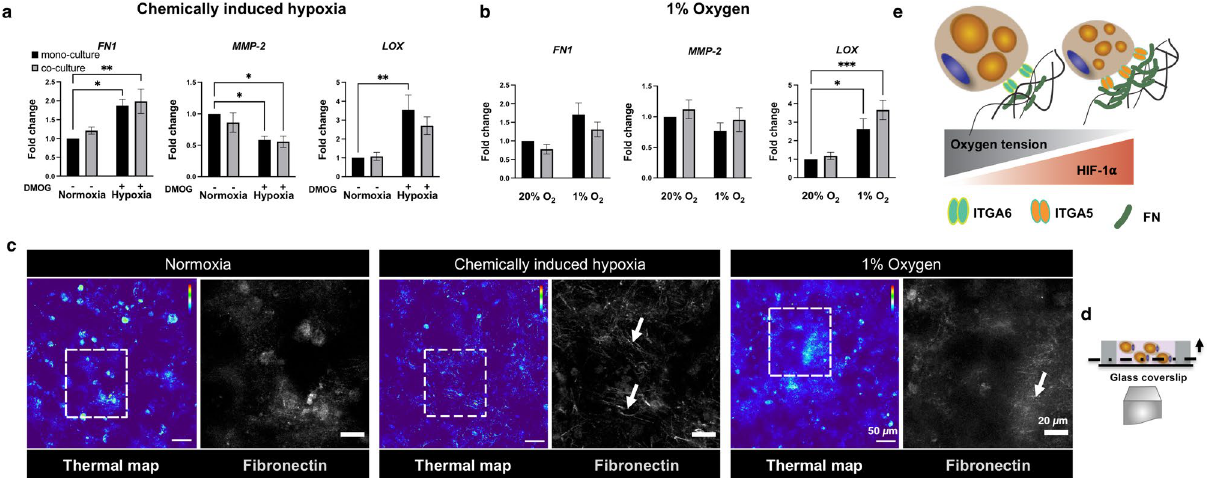
Figure 3. Hypoxia increases fibronectin, FN, and crosslinking gene, LOX , expression and results in a distinct fibronectin matrix assembly. ( a ) FN and LOX are significantly upregulated, while MMP-2 is downregulated in the chemically induced hypoxia (n = 8 biological replicates). ( b ) LOX was significantly upregulated in 1% oxygen (n = 8 biological replicates). ( c ) Fluorescent confocal microscopy images of the mono-culture AT constructs in normoxic (thermal map on the left and magnified view of ROI on the right) or hypoxic conditions (thermal map on the left and magnified view of ROI on the right) after 7 days (arrows point to the fibrillar structure of fibronectin, scale bar-50 µm, magnified images-20 µm). ( d ) Cross-section of AT constructs, fluorescent confocal microscopy images were taken at least 20 µm above the glass coverslip. ( e ) Hypoxia increases FN and LOX expression, and remodels fibronectin matrix into a fibrillar structure. Data are presented as means ± SEM. Comparisons between groups and statistical analysis were performed using two-way ANOVA with Tukey post hoc test (*p < 0.05, **p <